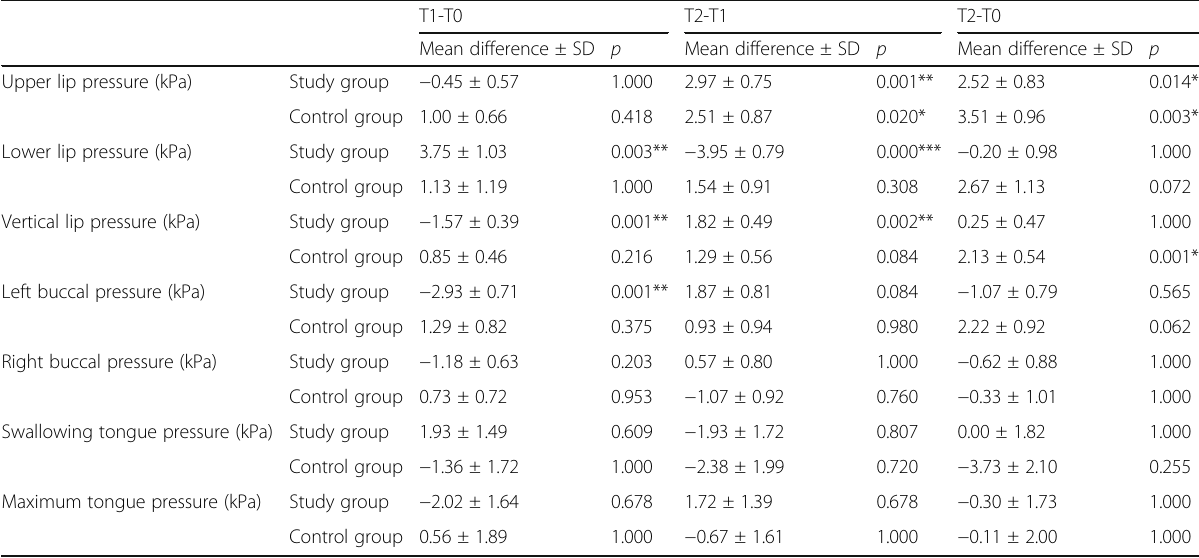
Table 5 Statistical analysis of the pressure changes in different treatment stages between the study and control groups